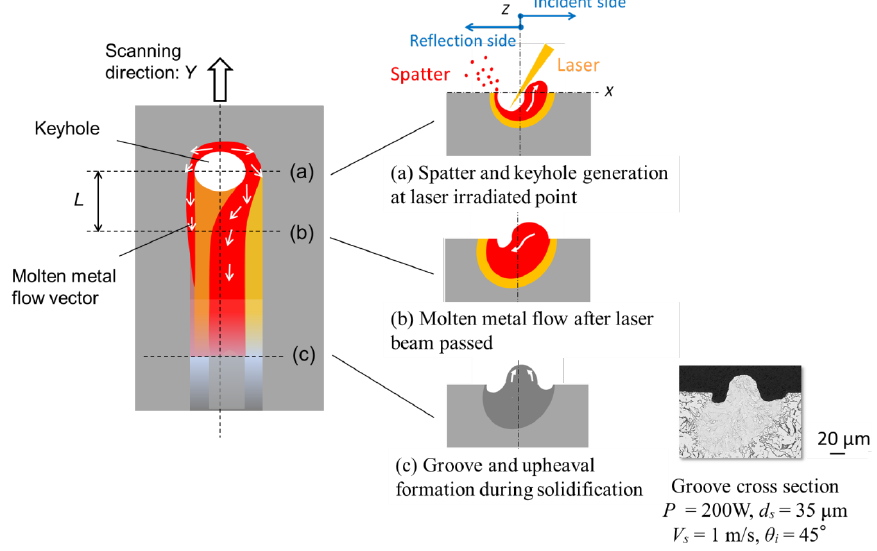
Figure 8. Schematic illustrations of molten metal behavior during angled laser irradiation with low-speed scanning (mild steel). Appl. Sci. 2020 , 10 , x FOR PEER REVIEW